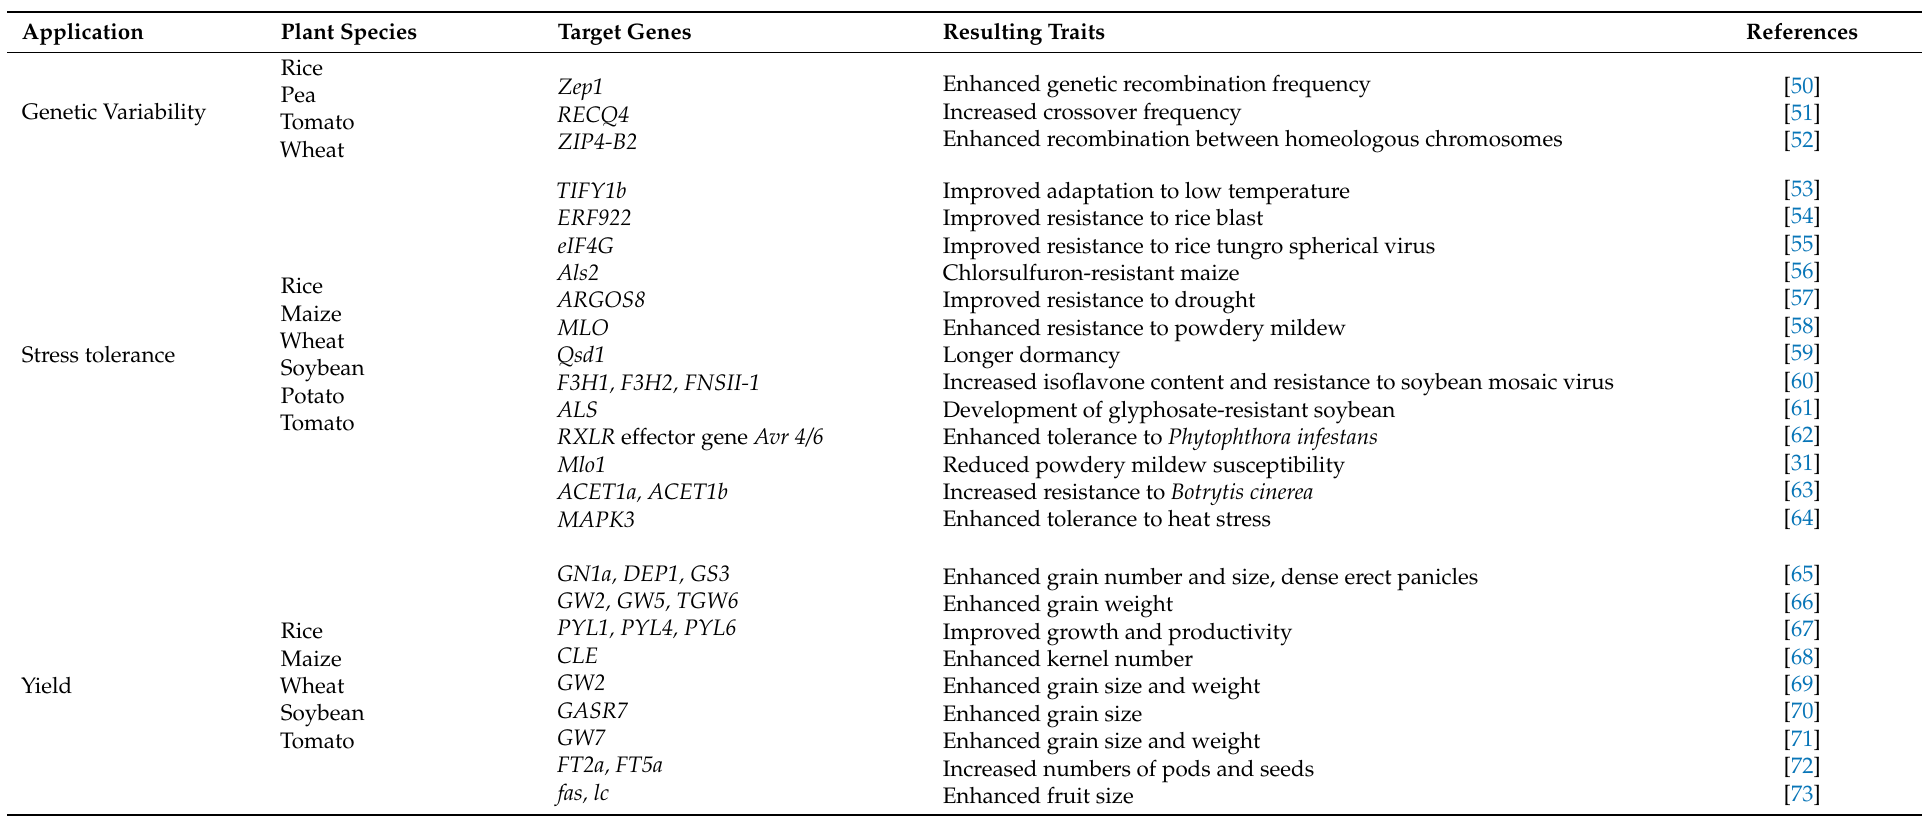
Table 1. List of CRISPR applications in crop species. Plant species, targeted genes and resulting traits are reported for each field of